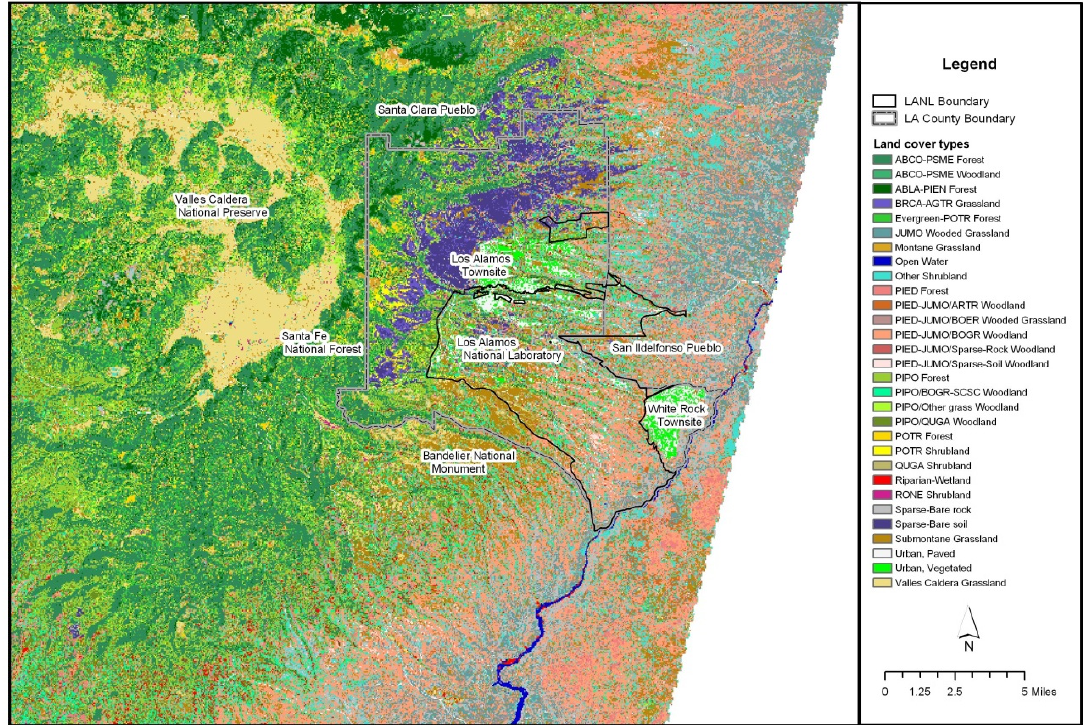
Figure 1. The eastern Jemez Mountains, including the region of interest in this study. The abbreviated species in the legend are included within the list of species in Appendix A (Table A1). Source: [10].